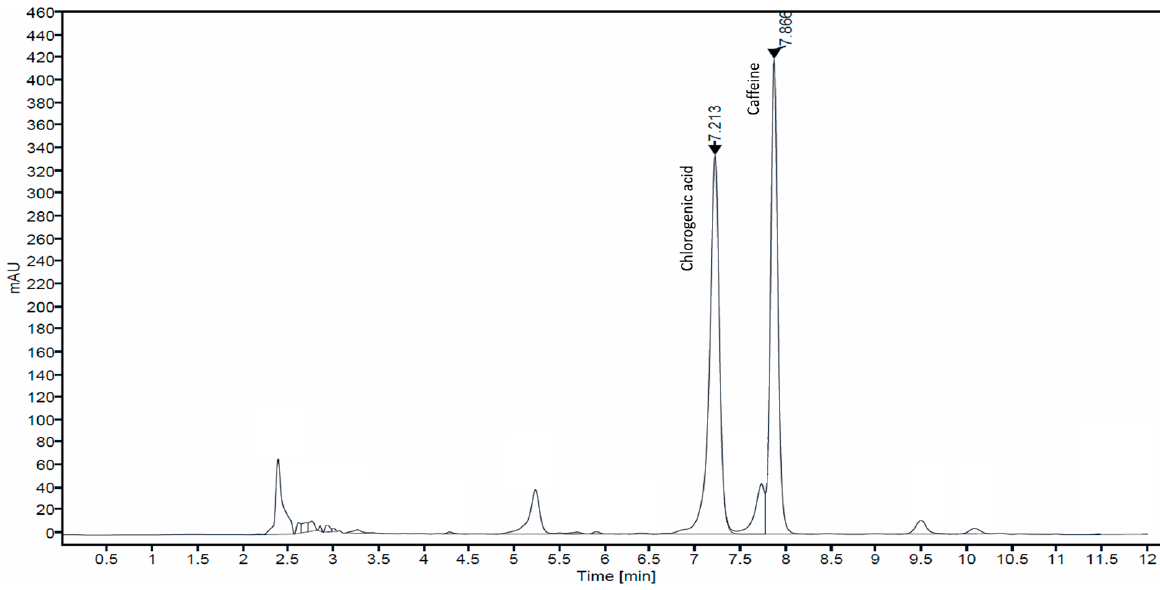
Figure 1. HPLC chromatogram of CBE.